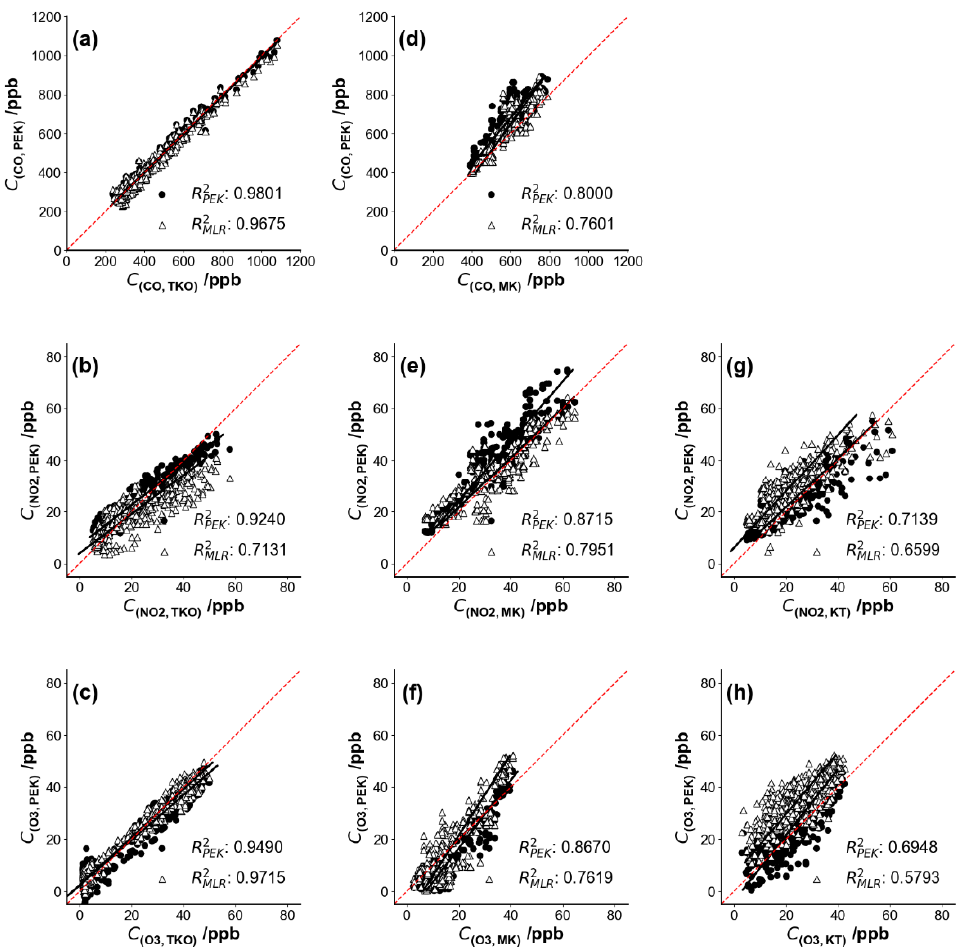
Figure 9. Scatter plots of gases measured by the Personal Exposure Kit (PEK) as PEK measurements under field co-location calibration condition (Methodology 2.3.1 (II)) against concentration values from fixed sites and R 2 for each scenario: ( a – c ) Tseung Kwan O (TKO), ( d – f ) Mong Kok (MK) and ( g , h ) Kwun Tong (KT) air quality monitoring sites. Note: Black dots refer to PEK measurement and open triangles indicate raw sensor output tuned using multi-linear regression. Data resolution is set as 5 min.